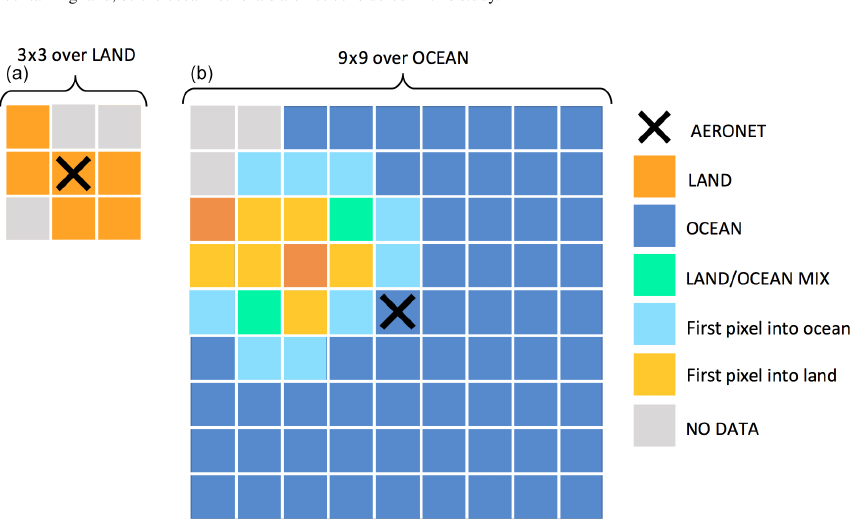
3 Validation of satellite observation by comparison with AERONET data: results and